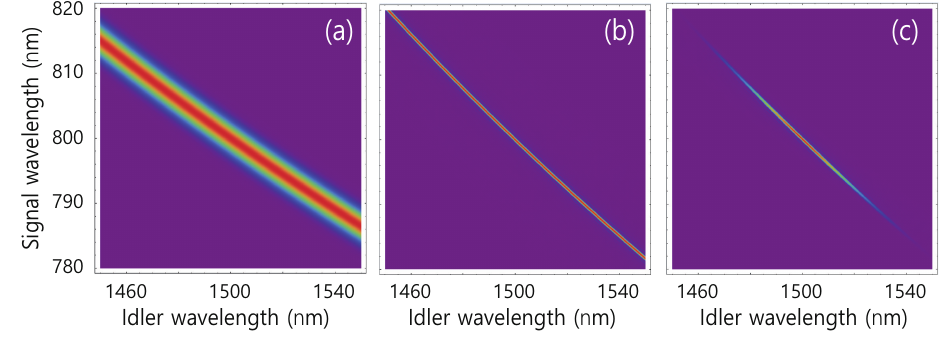
Figure 16. ( a ) Pump envelope function, | α ( ν s , ν i ) | 2 , governed by energy conservation. ( b ) Phase-matching function, | Φ ( ν s , ν i ) | 2 , governed by momentum conservation. ( c ) Joint spectral amplitude, | F ( ν s , ν i ) | 2 , as expressed in Equation (24). λ p = 1064 nm, ∆ λ p = 3 nm, and a 5 cm-long MNF with the 950 nm-diameter are used for numerical